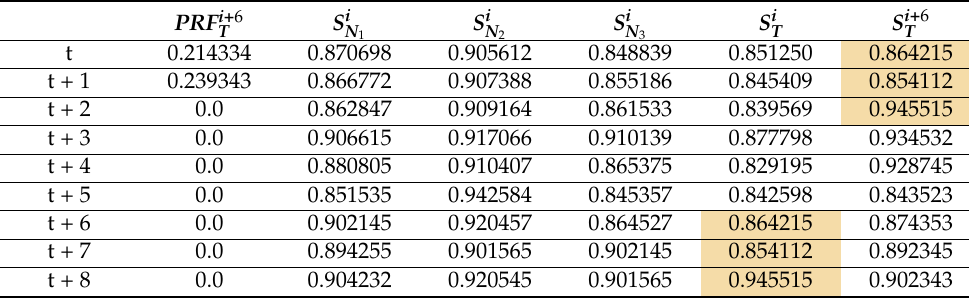
Table 2. Example training